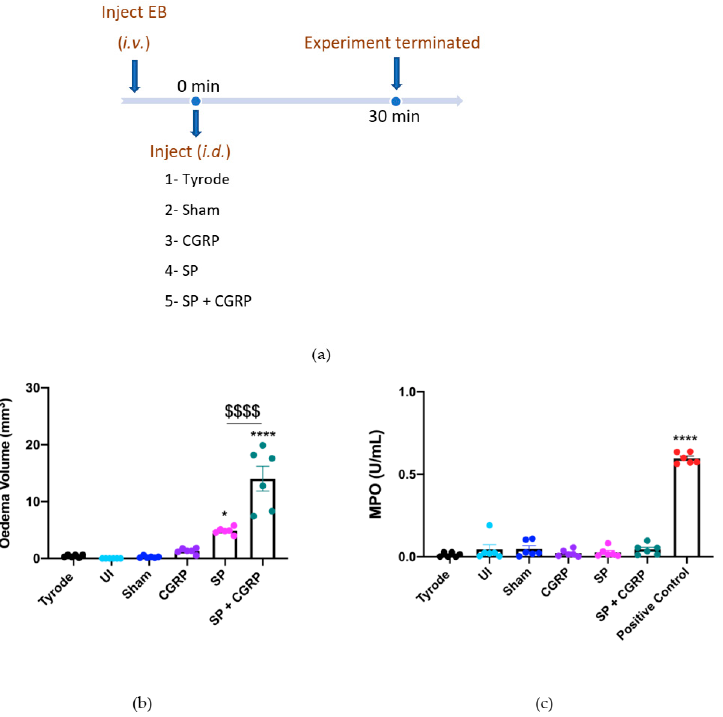
Figure 1. Calcitonin gene-related peptide, CGRP, potentiates oedema formation induced by sub- stance P, SP, over 30 min. ( a ) Timeline for studying the effect of exogenous CGRP on SP-induced oedema over 30 min. Oedema volume ( b ) and neutrophil accumulation ( c ) measured 30 min after administering into dorsal skin sites either controls, Tyrode (50 µL) or sham (0 µL); or test agents, CGRP (20 pmol/50 µL), SP (300 pmol/50 µL) or SP (300 pmol/50 µL) with CGRP (20 pmol/50 µL i.d.). An internal standard (zymosan-induced peritoneal exudate) was used as a positive control for MPO. Results are shown as mean ± SEM ( n = 6). One-way ANOVA with Bonferroni’s post hoc test. * p < 0.05, **** p < 0.0001 are compared to Tyrode. $$$$ p < 0.0001 is compared to SP.